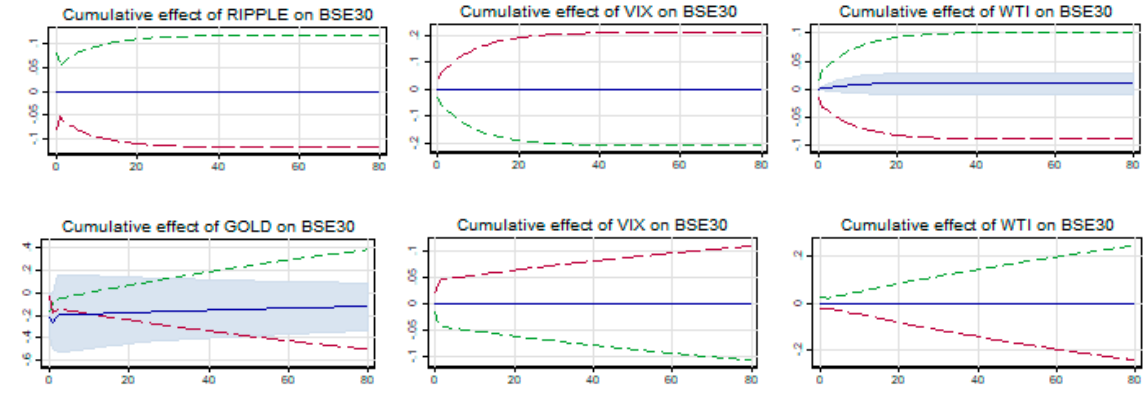
Figure 1. Cumulative effect of cryptos and gold on BSE30.